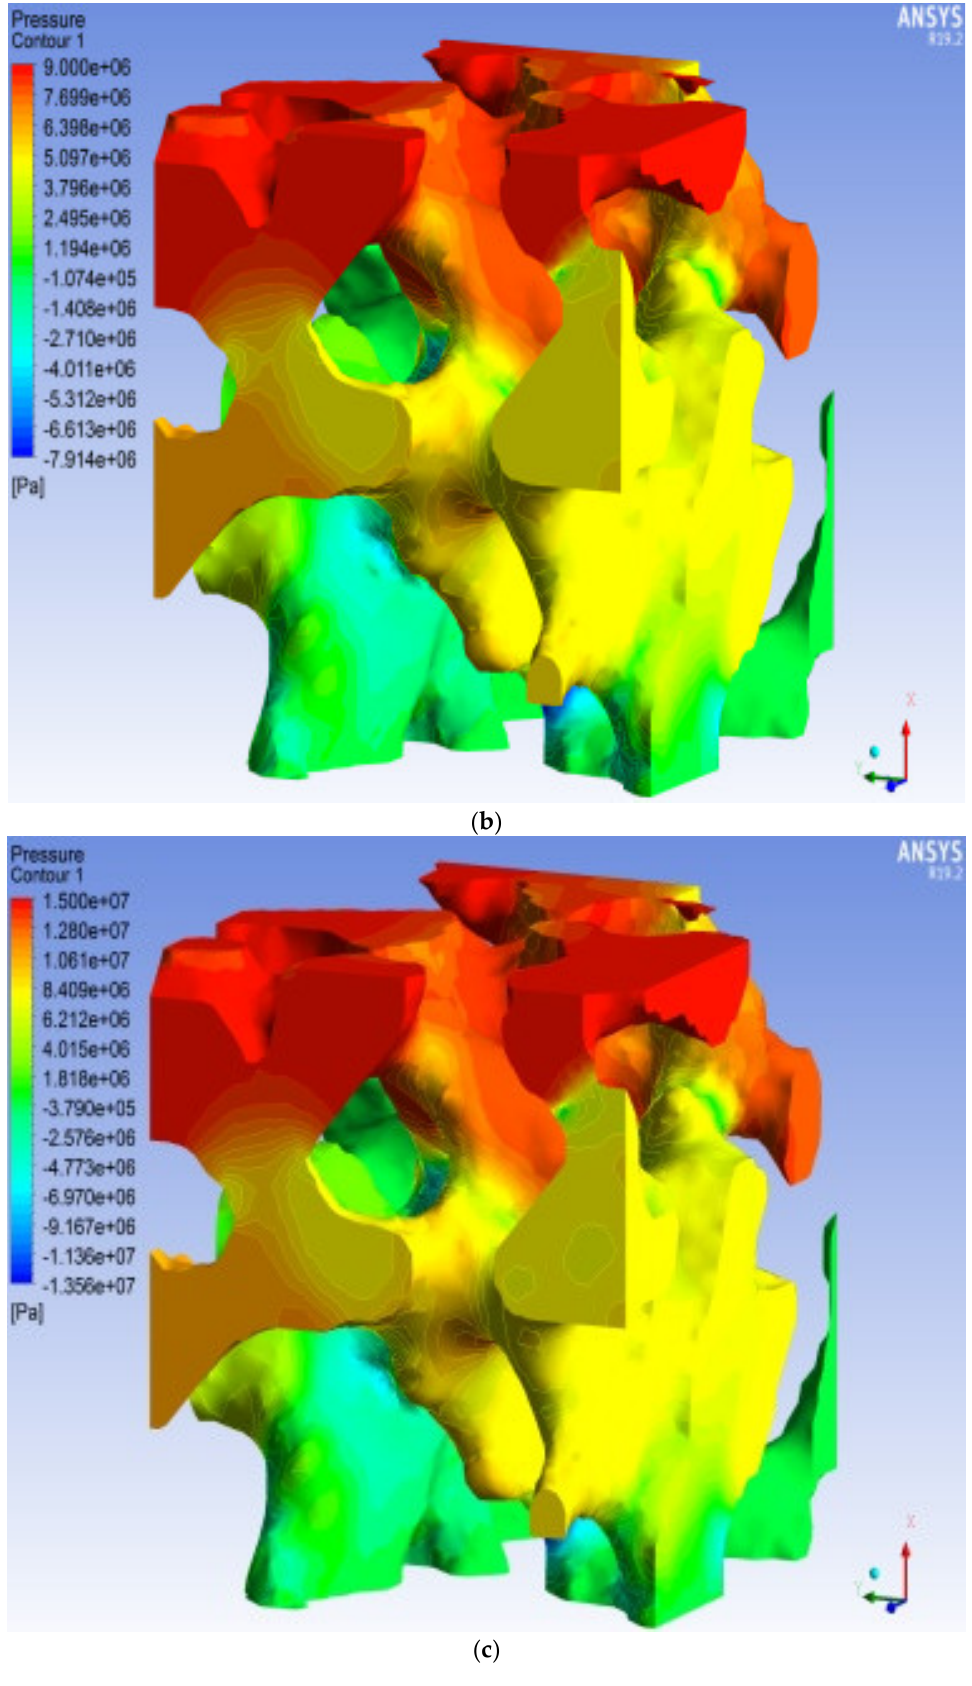
Figure 7. Pressure cloud diagram of the X direction entrance under different pressures.